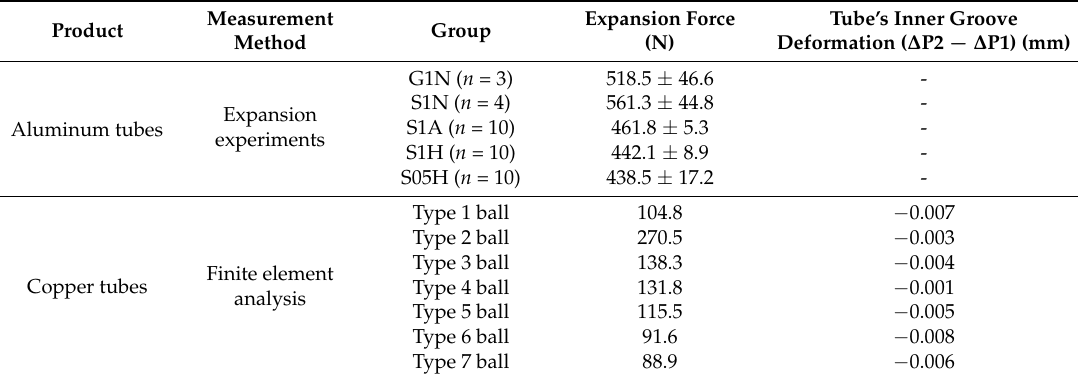
Table 4. Expansion force measured from Al tube expansion experiments and Cu tube expansion analyses and the deformation of tube’s inner grooves calculated from Cu tube expansion analyses.